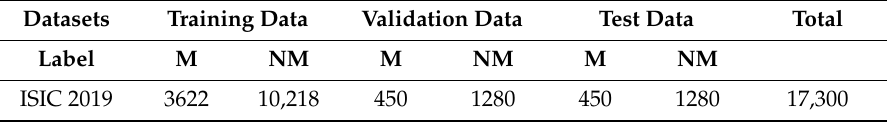
Table 4. Distribution of selected images from the ISIC 2019 dataset used in the proposed work.